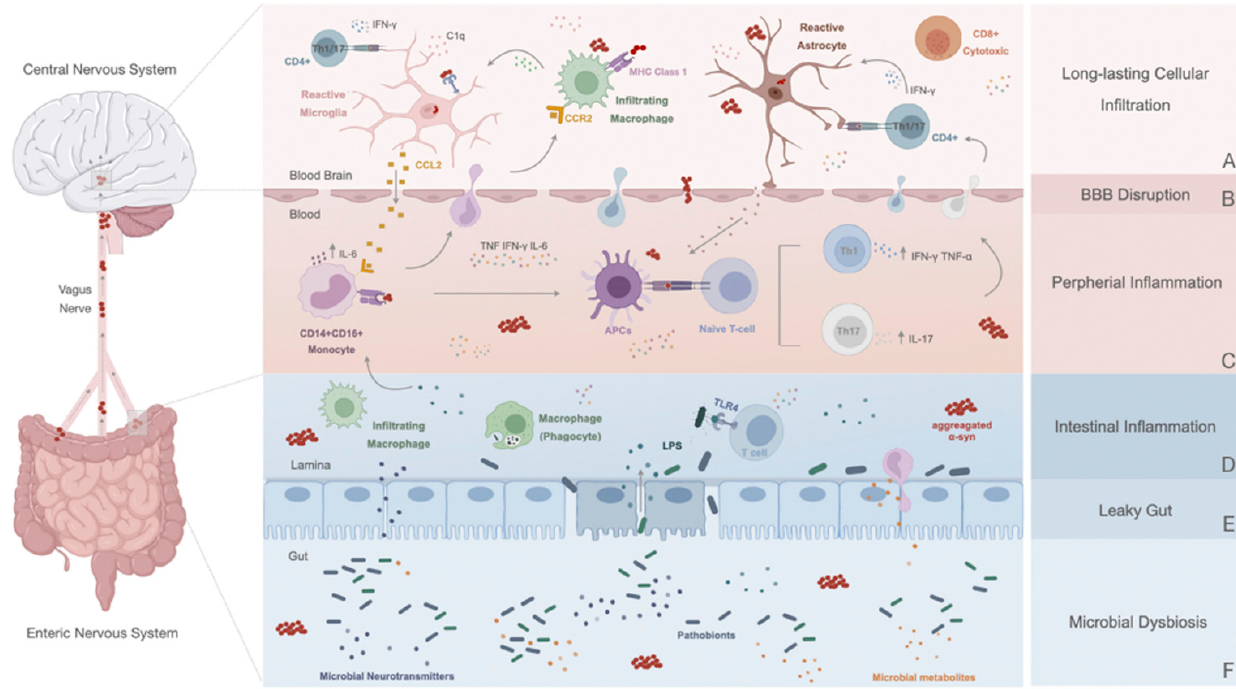
Figure 2. A multisystemic view on Parkinson’s disease neuroinflammation: from CNS gliosis to peripheral immune responses. ( A ) Once neuronal function declines and α -Syn accumulation changes, so will microglia and astrocyte response in PD. The PD brain reaches a chronic inflammatory state characterized by the release of high levels of proinflammatory mediators, continuous degeneration of DAn, and microglia/astrocytic activation. ( B ) With the loss of BBB functionality (associated with microglia and astrocyte reactivity), the exposure of the brain to blood-